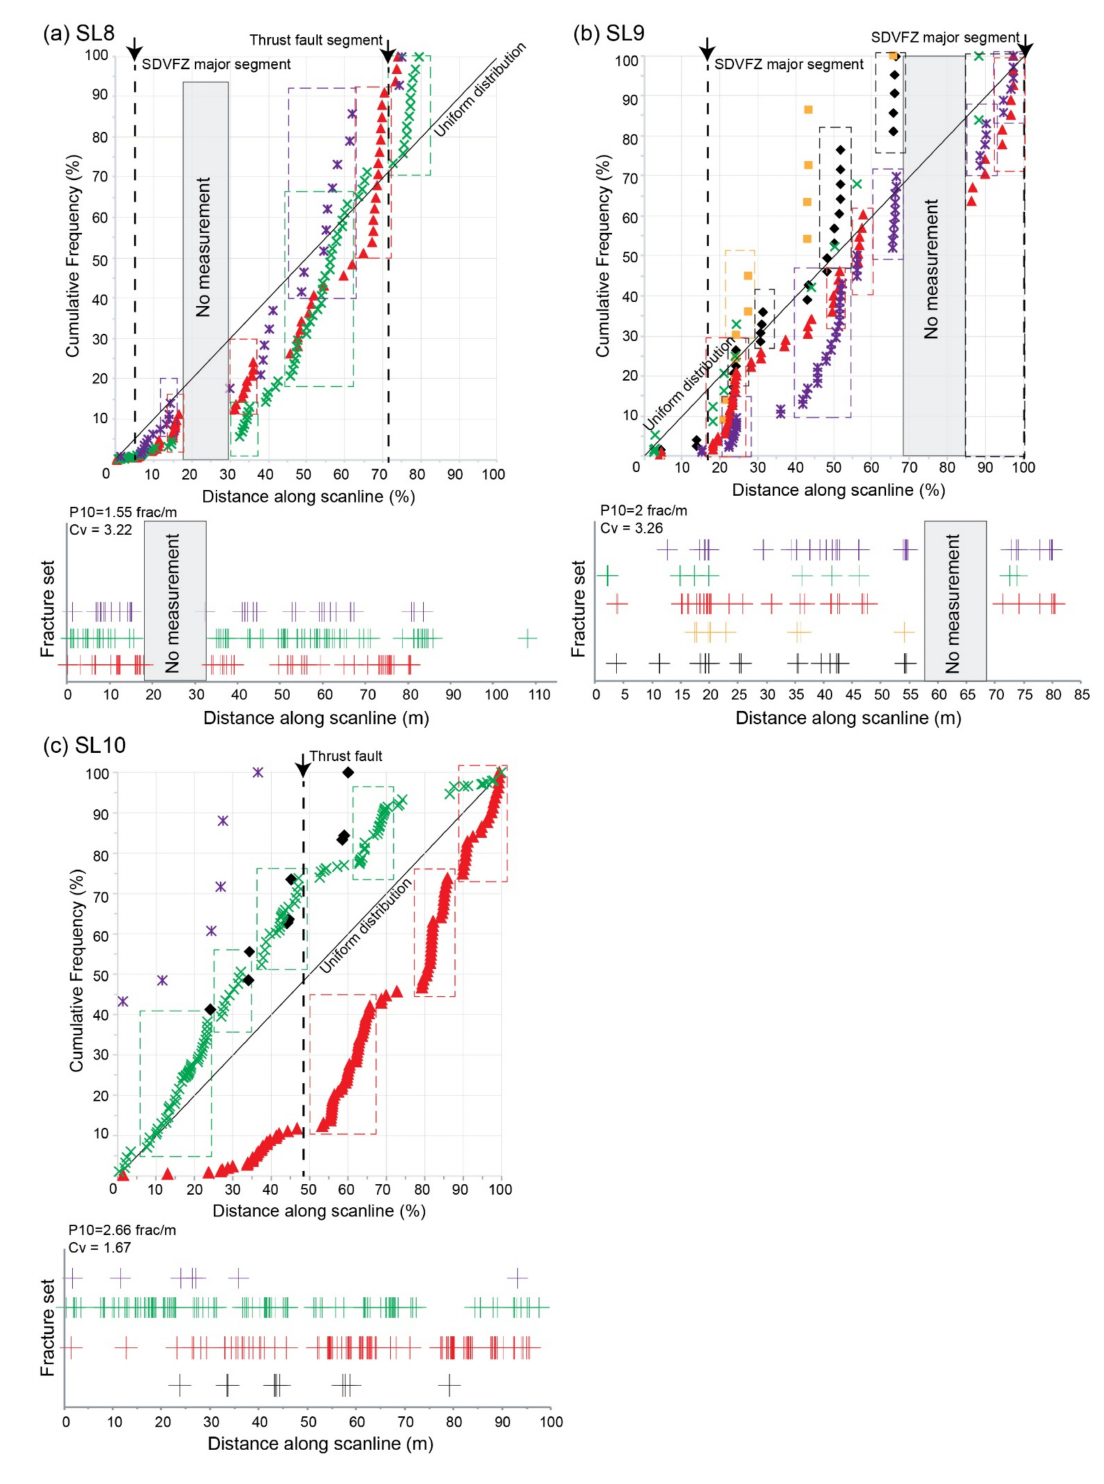
Figure 9. Cumulative frequency diagram along each scanline and following each fracture set (in colors). Plot of cumulative frequency expressed in % versus distance along scanline for: ( a ) SL8, ( b ) SL9, and ( c ) SL10. Dashed lines indicate a potential cluster for each fracture distribution, indicating a rapid increase in the number of fractures with slope threshold > 2. The diagonal line in each plot of cumulative frequency defines a uniform or regular distribution. Visual location of fractures expressed in stick plots for each fracture set distribution, showing the fracture position along the scanline, including the fracture density (P 10 ) and the coefficient of variation (Cv) values. See the color legend in Figure